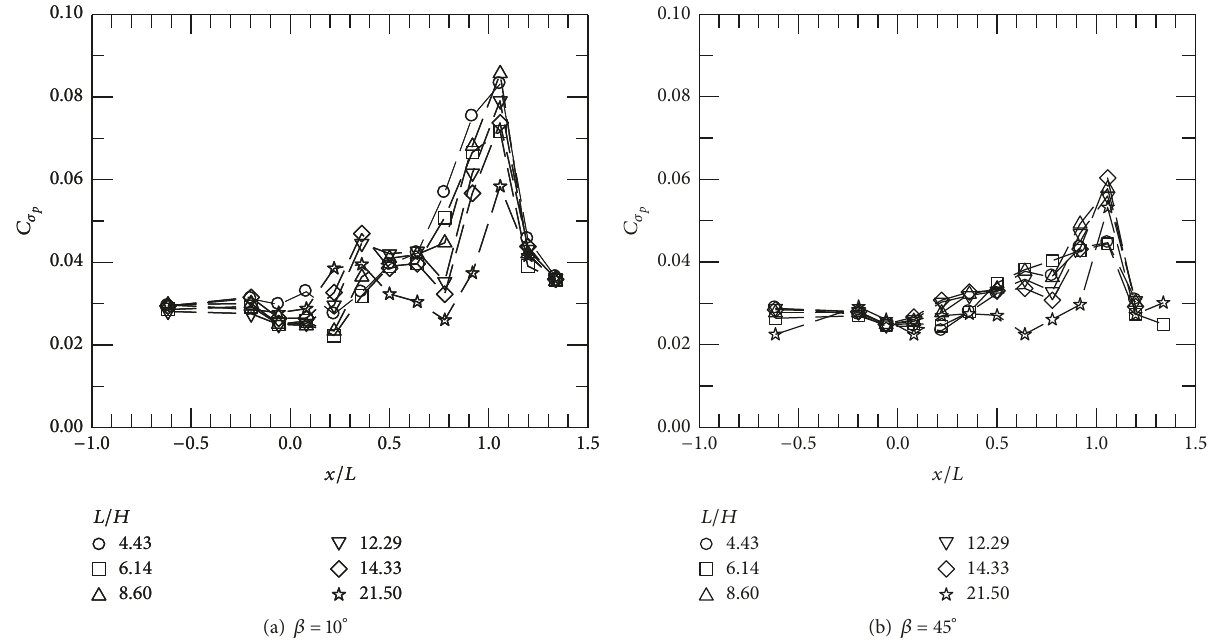
Figure 6: Chord-wise distributions of surface fluctuating pressure for M = 0.83: (a) 𝛽 = 10 ∘ and (b) 𝛽 = 45 ∘ .